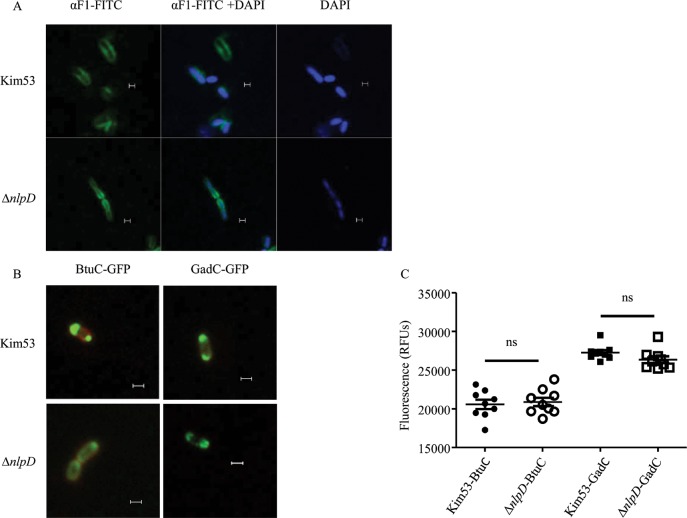
The Sec translocon is operational in the ΔnlpD mutant.A. The indicated bacterial cells were labeled with FITC-conjugated α-F1 antibodies (left), DAPI (right) or both α-F1 and DAPI (middle). B. Fluorescence microscopy of Y. pestis strains expressing the Sec-substrates BtuC and GadC fused to GFP. Scale bar = 1 μm. C. Relative fluorescence units (RFUs) of the ΔnlpD mutant expressing BtuC-GFP or GadC-GFP, compared to the wild Kim53 strain expressing the reporter proteins, according to [40]. Ns, non-significant (Unpaired t test). The data presented are representative of at least two independent experiments and the displayed data in A and B is one representative experiment.